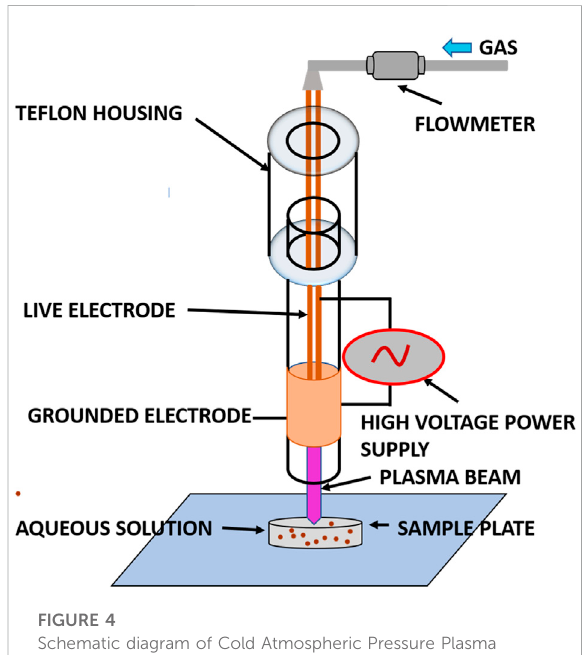
FIGURE 4 Schematic diagram of Cold Atmospheric Pressure Plasma treatment on aqueous